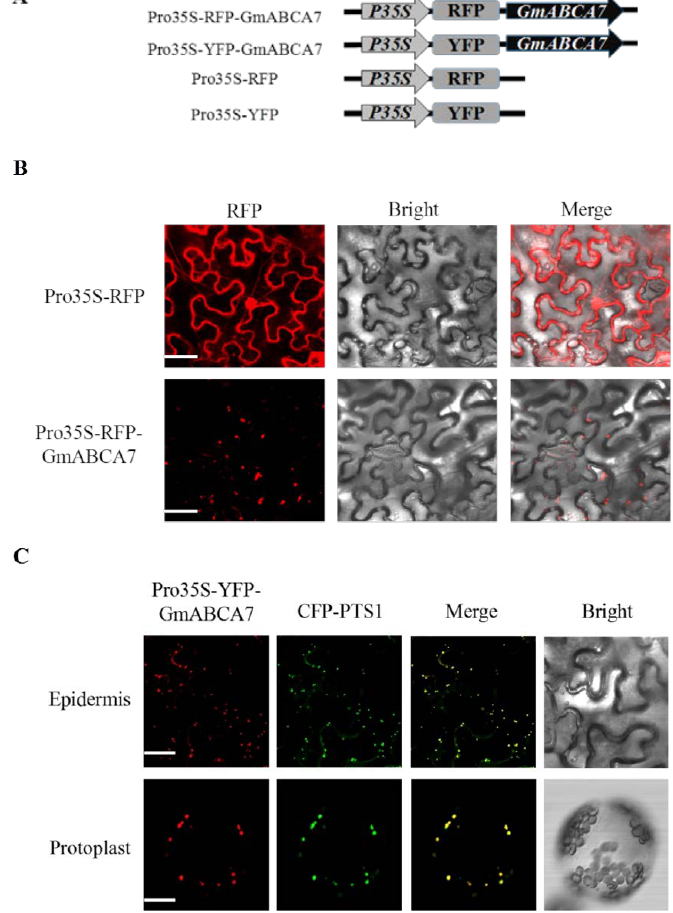
Figure 2. Subcellular localization of GmABCA7 in leaf epidermal cells of Nicotiana benthamiana. ( A ) Diagram of the Pro35S-RFP-GmABCA7, Pro35S-YFP-GmABCA7, Pro35S-RFP and Pro35S-YFP vectors. ( B ) The GmABCA7 cDNA was fused at the C terminus of RFP under the control of a CaMV 35S promoter, Pro35S-RFP-GmABCA7. Pro35S-RFP expressed tobacco epidermal cells were used as a control. Bars = 50 µm. ( C ) Co-expression of Pro35S-YFP-GmABCA7 with CFP-PTS1. CFP-PTS1 was used as a marker for peroxisome. Protoplasts were from tobacco leaves co-expressing with CFP-PTS1 and YFP-GmABCA7. RFP, red fluorescent protein. YFP, yellow fluorescent protein. CFP, cyan fluorescent protein. Bars = 20 µm.